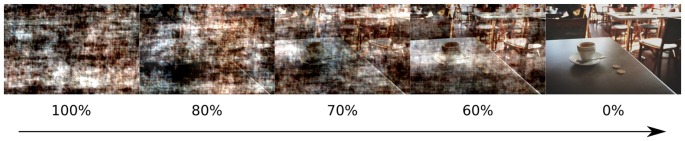
Example of images with superimposed noise, analogous to those presented in the experiment. Percentage of noise content is indicated below each image.